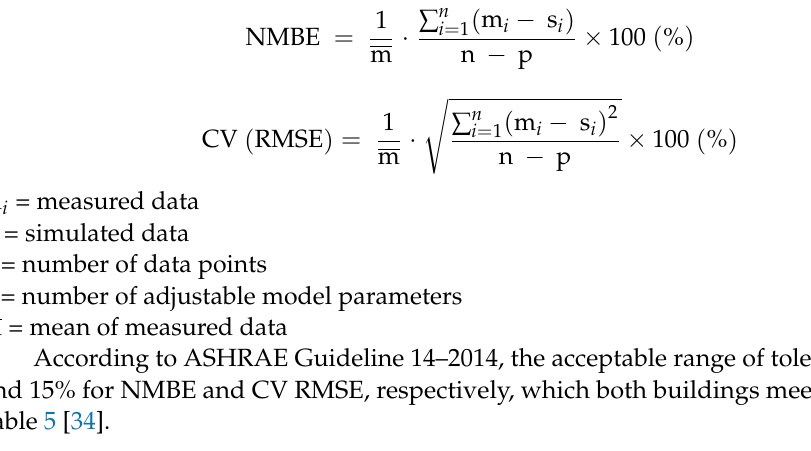
Table 5. NMBE and CV RMSE calibration values for Hudhayfah and Al Wafi mosques. Mosque NMBE CV RMSE Hudhayfah Mosque 2% 14% Al Wafi Mosque 1%